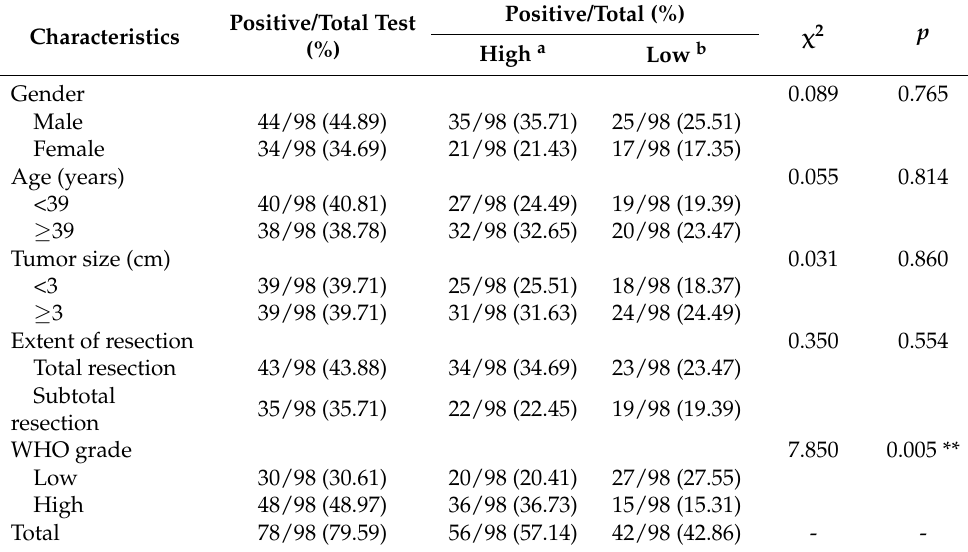
Table 3. Association between the MAGED2 protein and clinical characteristic of glioma patients ( n =